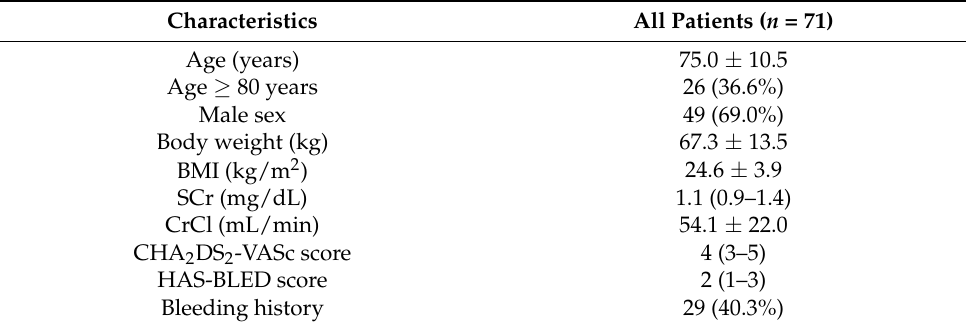
Table 1. Baseline characteristics for all